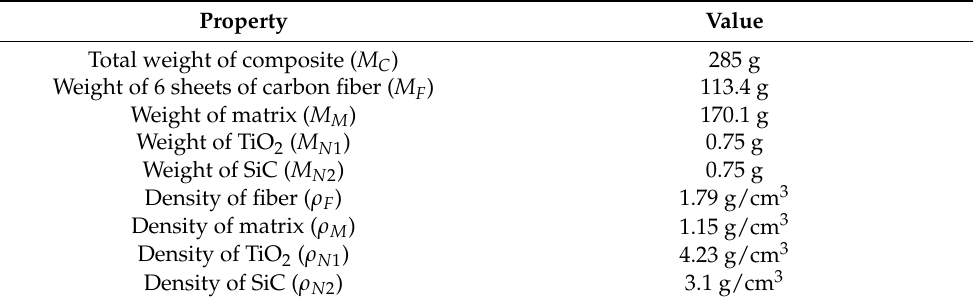
Table 7. Calculation